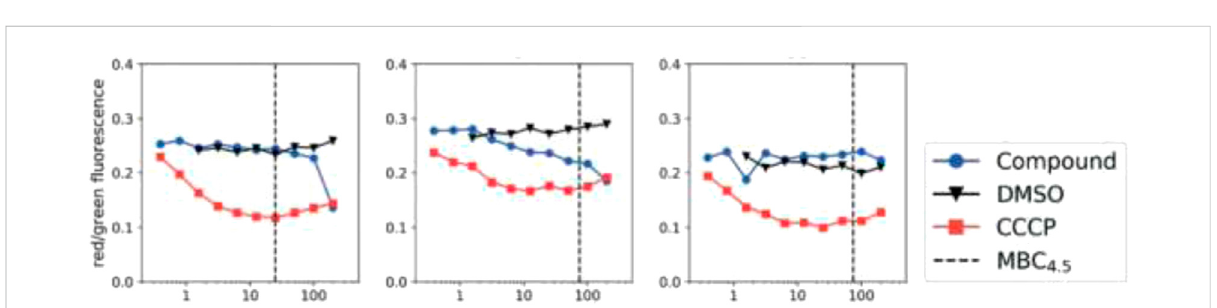
FIGURE 11 Examples of imidazobenzothiazole.